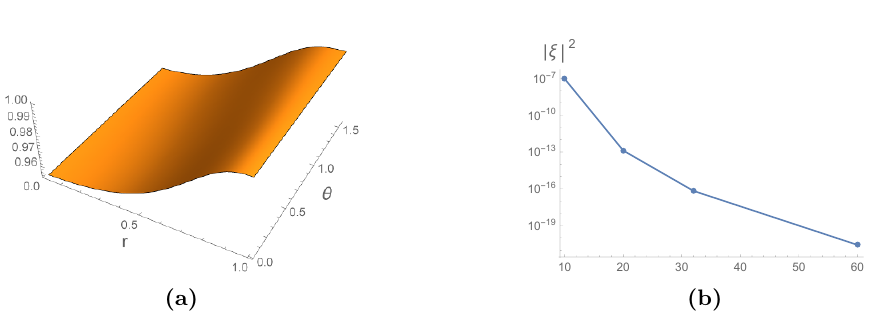
Figure 1. (a) Metric function A for log plot of the deTurck vector norm, a measure of convergence, as a function of the number of gridpoints n